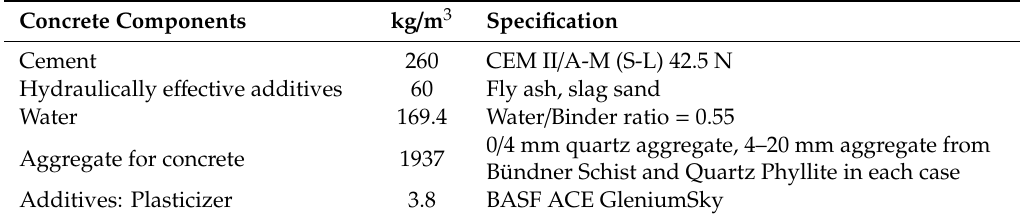
Table 3. Recycled aggregate concrete mix design [30].